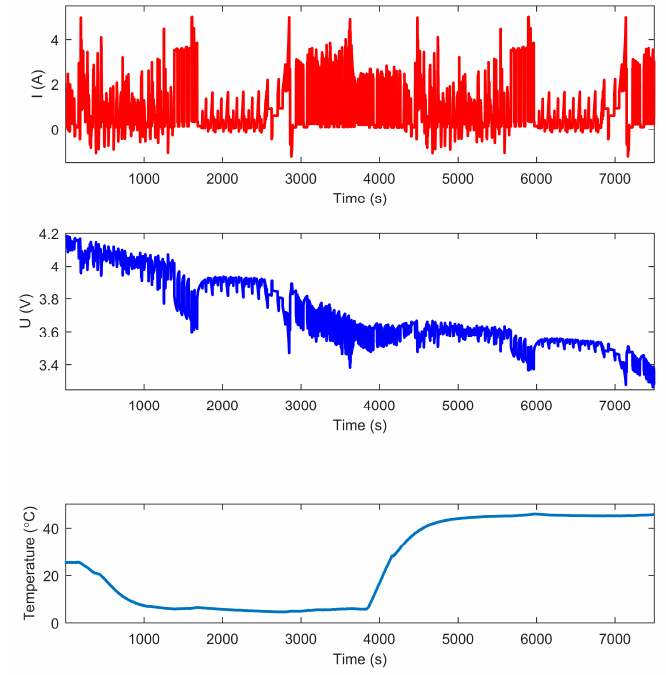
Figure 7. Working condition test.